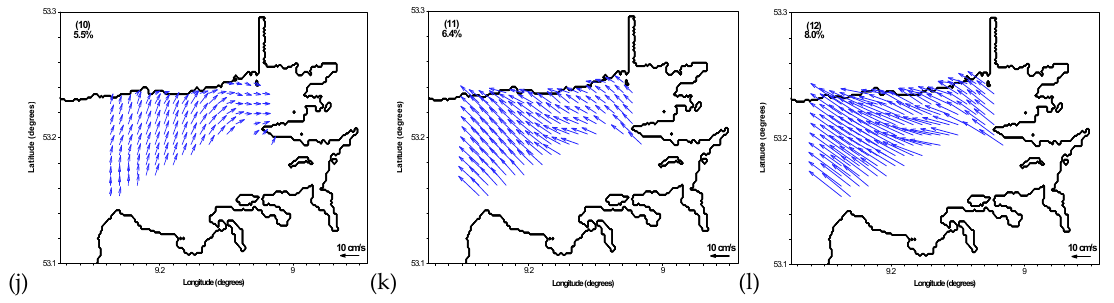
Figure 4. Characteristic spatial patterns of surface currents from radar extracted by a 4 × 3 SOM analysis (subfigures ( a – l ) indicates twelve spatial SOM patterns, respectively; the occurrence frequency is given as a percentage number for each pattern at the topleft).